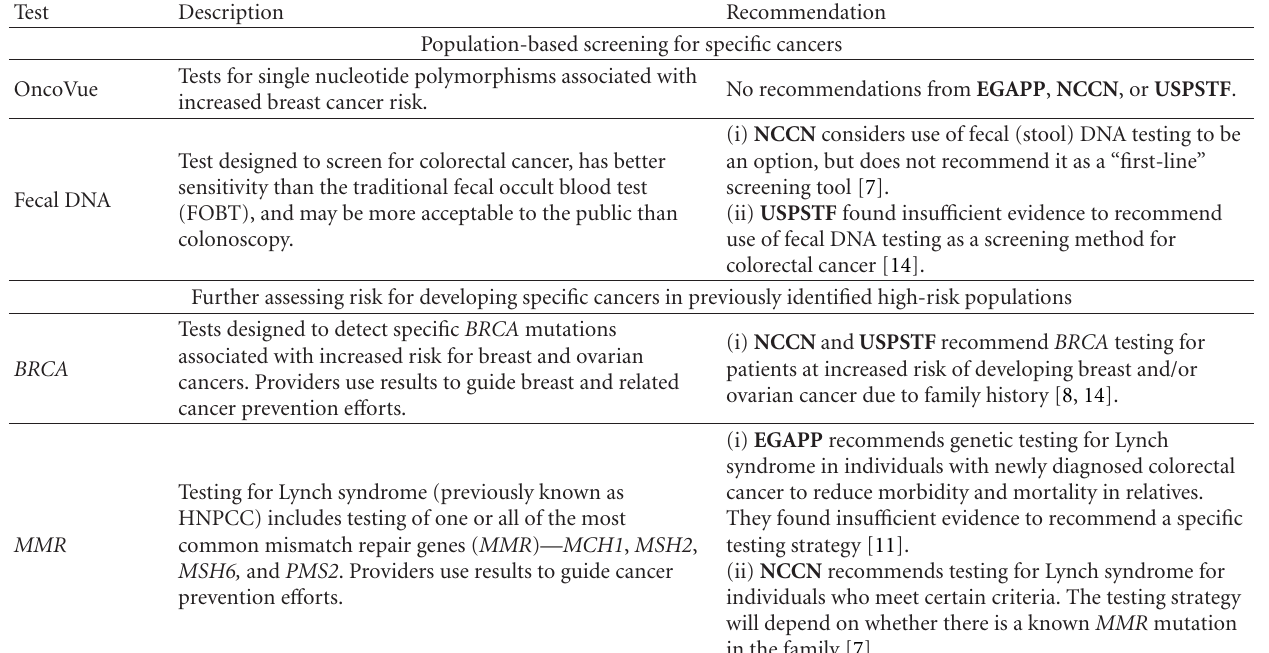
Table 1: National guidelines for cancer genetic tests included in the 2010 Oregon Health Care Provider